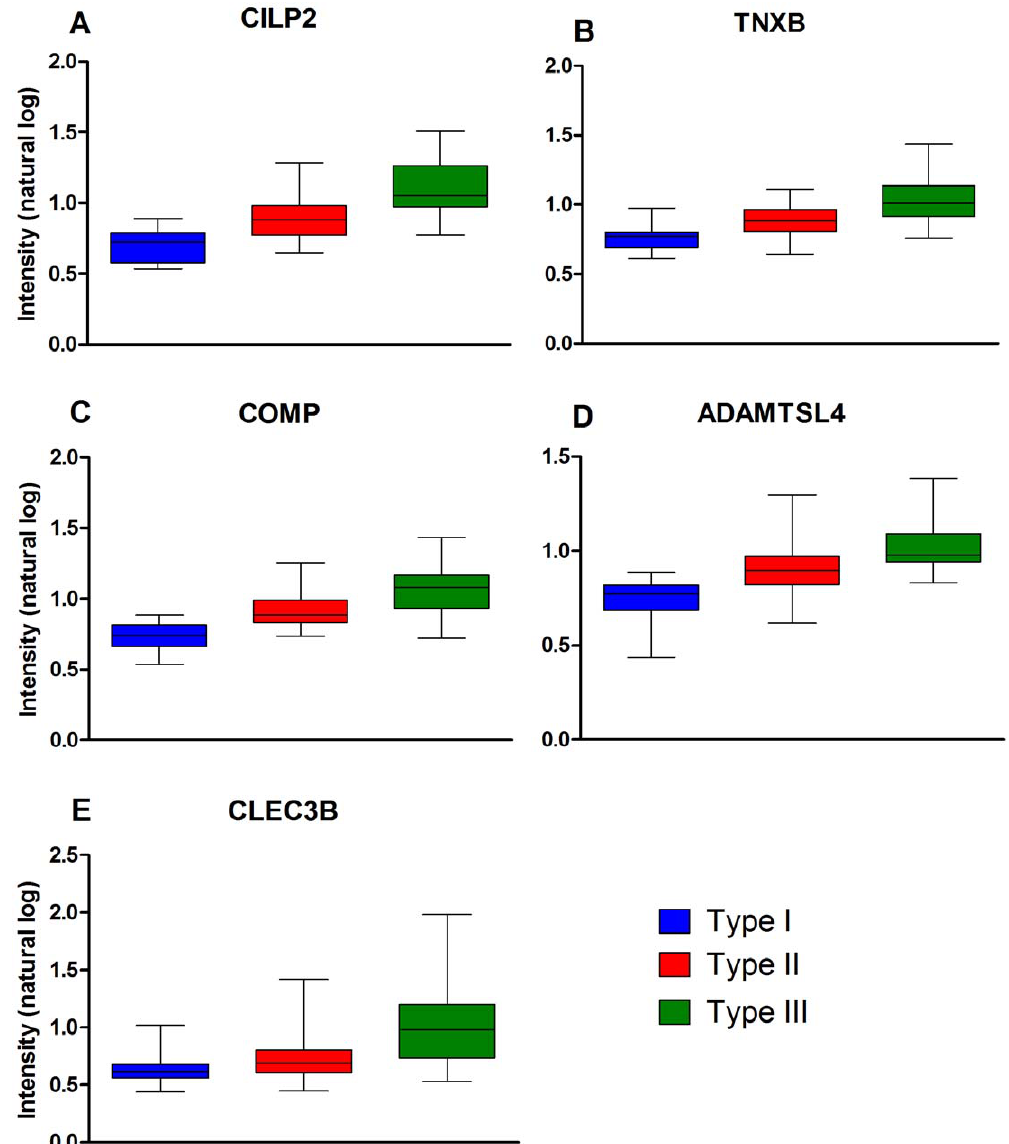
Figure 3. Illustration of the top 5 markers as candidate biomarkers by Type. The natural log intensity of the protein abundance of CILP2, TNXB, COMP, ADAMTSL4 and CLEC3B are shown (Panels A-E) by Type. Error bars are expressed as standard errors. minimum MHFMS value. Because ceiling and floor values will increase (positive) or decrease (negative) slopes of identified associations, and alter the correlation strength in an unknowable way, we conducted a post hoc test analysis of the primary outcome measure removing subjects having these border values. This post hoc approach, by decreasing the number of subjects, will necessarily decrease the power of the statistical models. Nonethe- less, the strongest hits as ranked by Q-value were reproduced when the border-score subjects were removed from the analysis. Given the restricted range of the MHFMS and some of the supplemental measures, it is notable that identified candidate makers that were found to discriminate between high or low functioning SMA subjects were generally consistent across all outcome measures employed in the study (MHFMS, Current Level of Function, Respiratory Support, and Feeding Method).